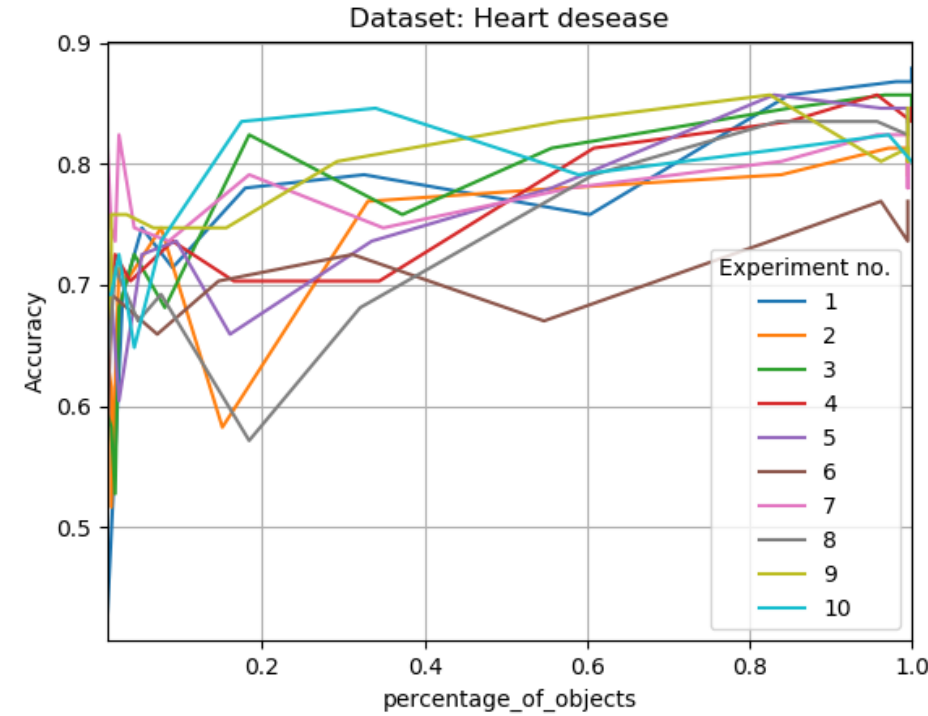
Figure 5. Results for 10 learning cycles, using 10 splits; for Heart Disease data set; In ‘percentage of objects’ ax, we have the percentage size of granulated data vs accuracy of classification in ‘Accuracy’ ax; in. The results are not perfectly evenly matched or at the same points on the x-axis, due to the fact that the size reduction levels of the training systems varied.